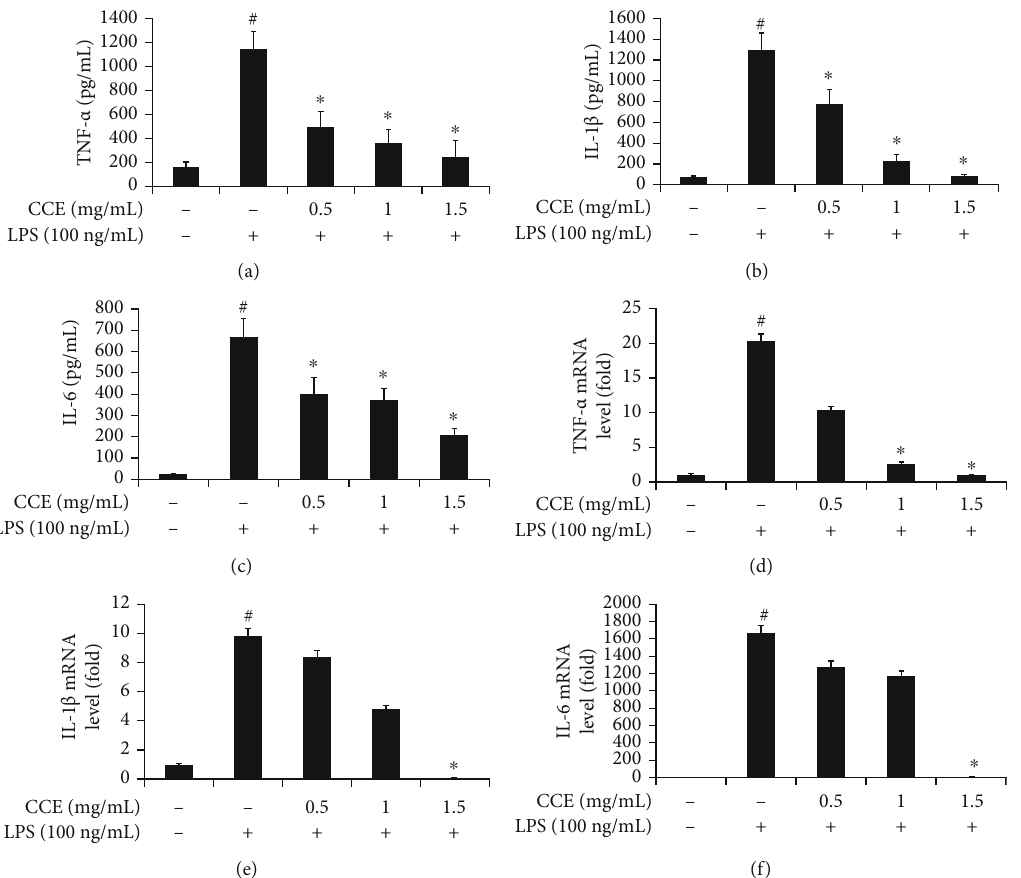
Figure 4: E ff ect of Commelina communis extract (CCE) treatment on lipopolysaccharide- (LPS-) induced production of cytokines such as tumor necrosis factor- (TNF-) α , interleukin- (IL-) 1 β , and IL-6 in RAW 264.7 cells; protein expression (a – c) and mRNA expression (d – f). Cells were pretreated with the indicated concentrations of CCE (0.5, 1, and 1.5mg/mL) for 4 h and then exposed to LPS for 24h. Cell supernatants were analyzed using enzyme-linked immunosorbent assay and real-time polymerase chain reaction. The experimental results, in triplicate, are indicated as the mean ± standard deviation . # P < 0 : 05 compared with the control; ∗ P < 0 : 05 compared with the LPS-exposed